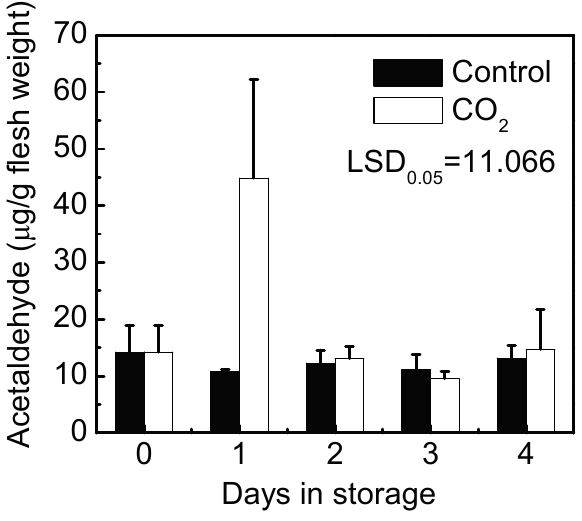
Figure 2. Comparison of tannin printing of control and CO 2 treated “Mopan” fruit at 2 days in storage.